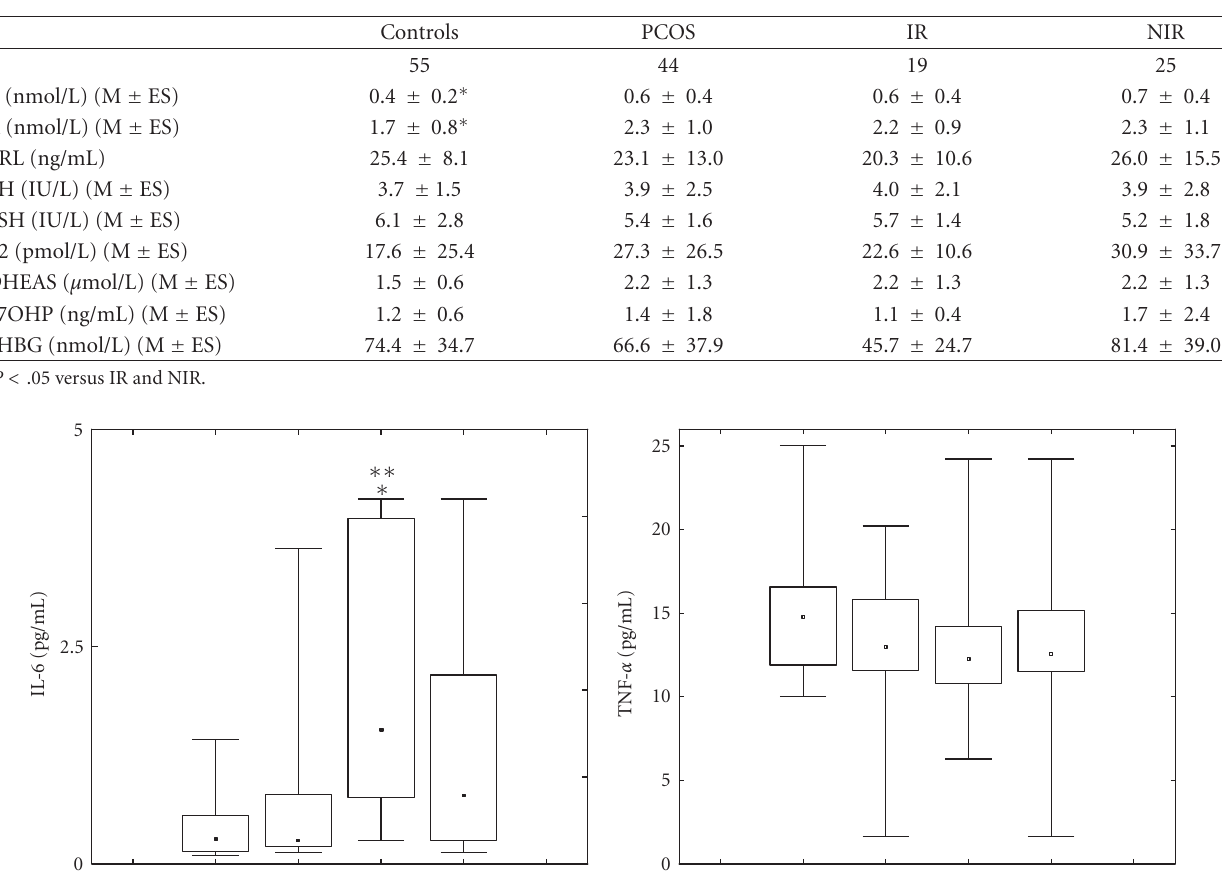
Table 2: Hormonal characteristics of the study population (mean ± SD).